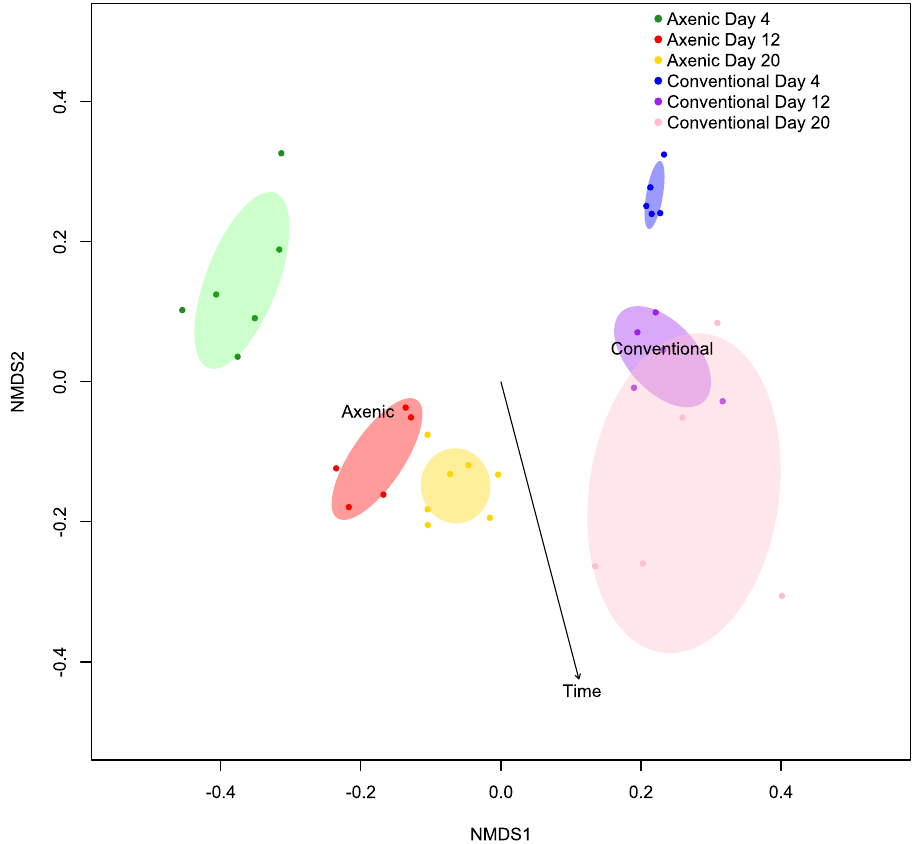
Figure 4. Similarity between expression profile of DETs in axenic and conventional larvae. Ordination based on samples transcripts by Jaccard test with non-parametric distances (N = 5). The test is fitted with time as numeric variable (confidence interval = 99% inside